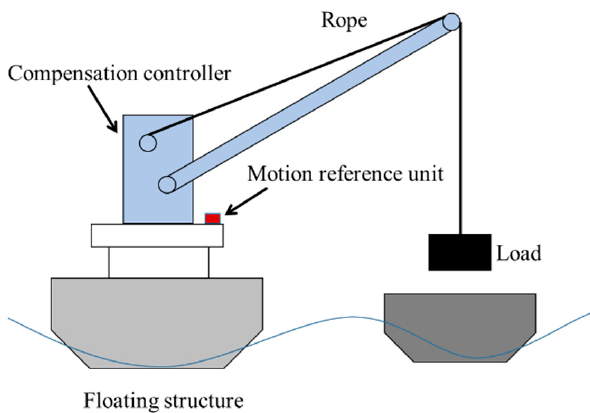
Figure 1. Sketch of the active heave compensation system for an offshore crane.